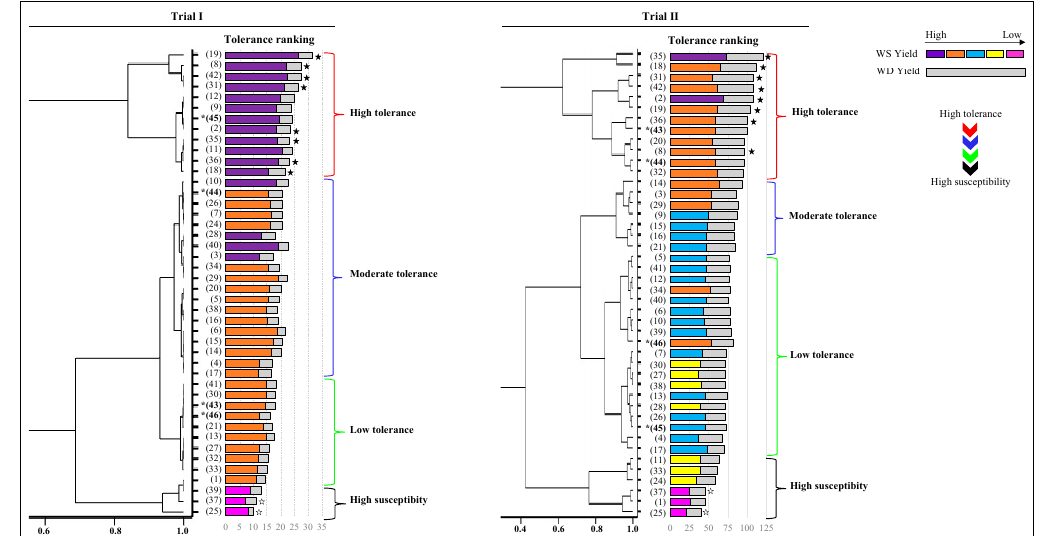
Figure 4. Cluster analysis of drought tolerance ranking for the 44 A. tricolor accessions calculated based on the GMP, MP and STI values in Trial I and Trial II. The dendrogram discriminates amaranth into four drought tolerance rankings (high, moderate and low tolerance, and high susceptibility). Data represent mean of yield under water-sufficient (WS) and water- deficient (WD) conditions; *43, *44, *45, *46 accessions check variety. Black star represents tolerant accession and white star represents susceptible accessions, consistent in both trials .